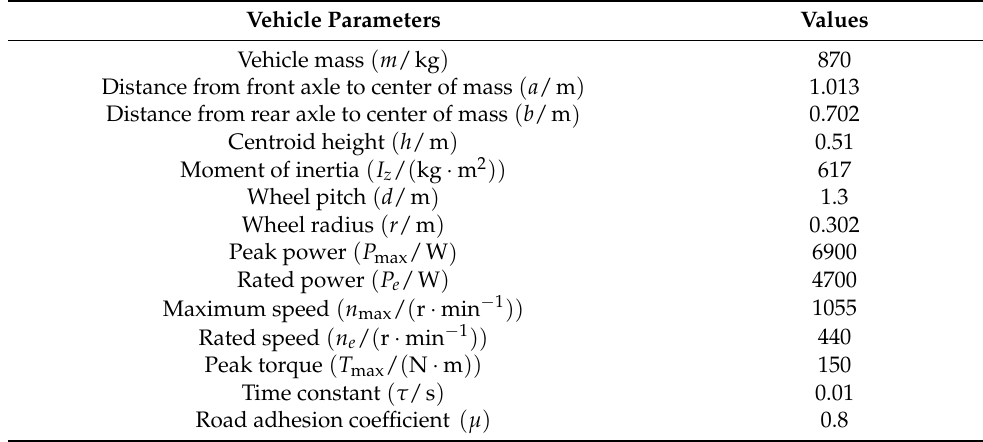
Table 2. Vehicle model parameters.